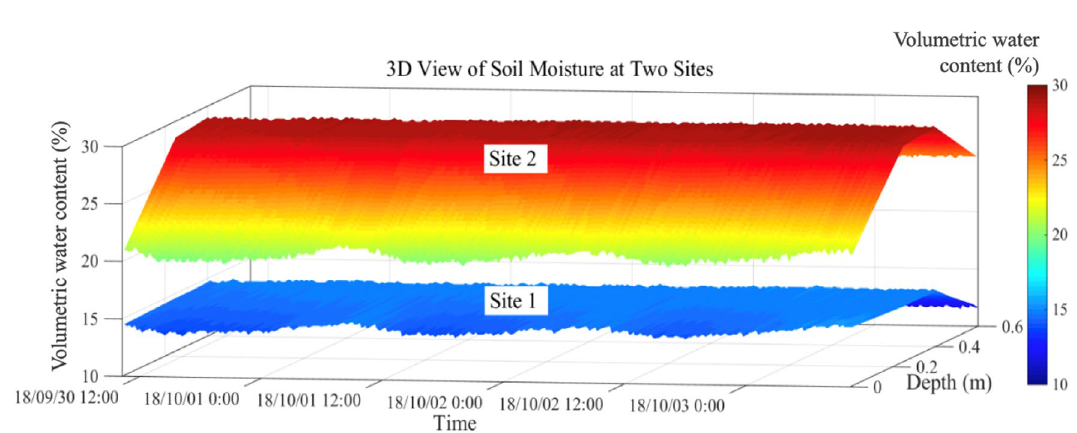
Figure 8. 3D view of soil volumetric water content from 0 to 0.6 m depth at sites 1 and 2 over a three-day period. Soil moisture contents at depths of 0.1, 0.25, 0.4, and 0.6 m were measured with hygrothermographs; values at other depths were calculated by linear interpolation.